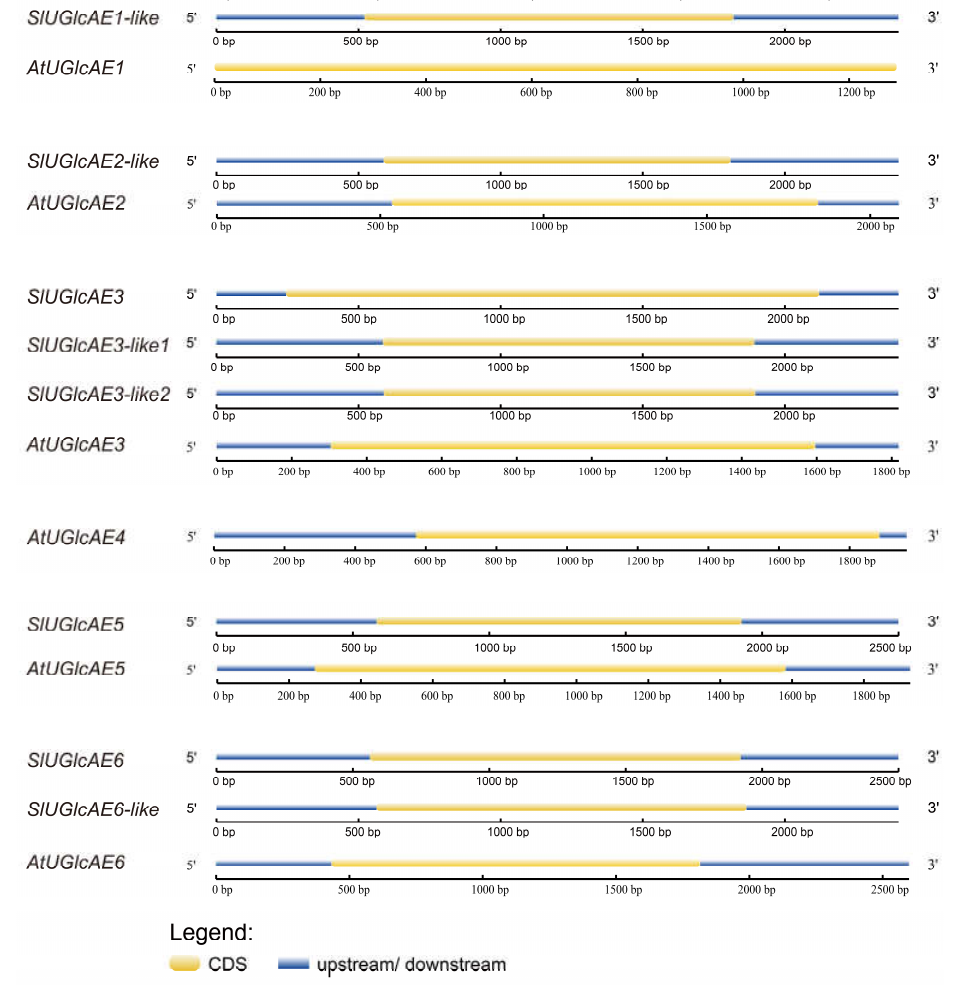
Figure 2. Exon‐intron structures of nine tomato UGlcAE genes and six Arabidopsis thaliana UGlcAE genes. The yellow sections represent the exons, and the blue parts indicate upstream/downstream regions.